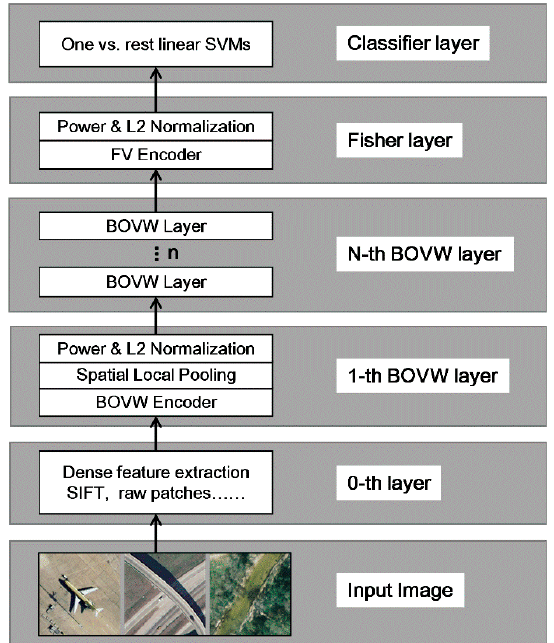
Figure 1. The architecture of the proposed Hierarchical Coding Vector (HCV). The representation of HCV is deeper with richer semantic information by constructing a hierarchical coding structure. SVMs, Support Vector Machines; FV, Fisher Vectors; BOVW, Bag of Visual Words; SIFT, Scale Invariant Feature Transformation. Table 1. The definitions of parameters used in this